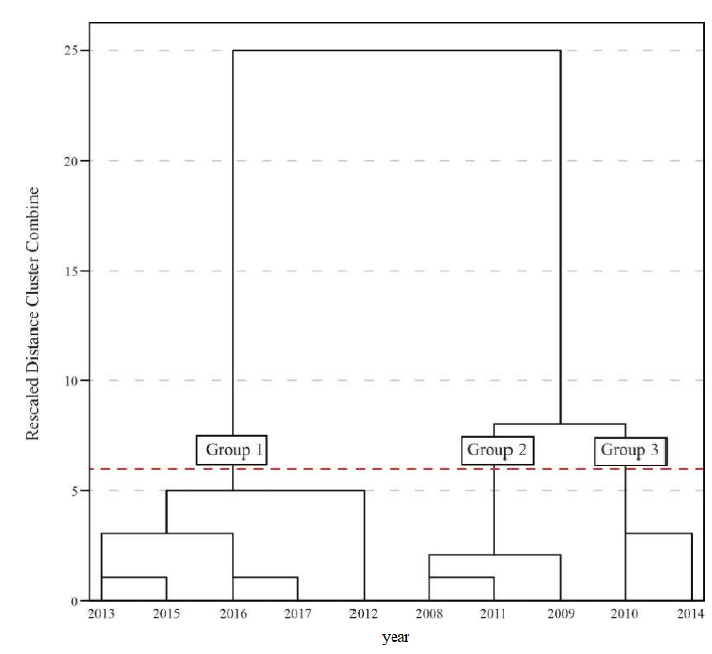
Figure 3. Grouping dendrogram of homogeneous years for the district of Iguatu, Cear á , Brazil. Table 1. Mean values and standard deviations of the climate variables for each group formed, for the district of Iguatu, Cear á ,